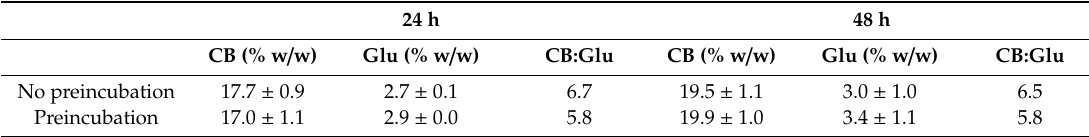
Table 1. Cellulose conversion (% w/w) to CB and Glu with and without preincubation of the enzyme with the inhibitor compound. Birch B1 was used as a substrate.